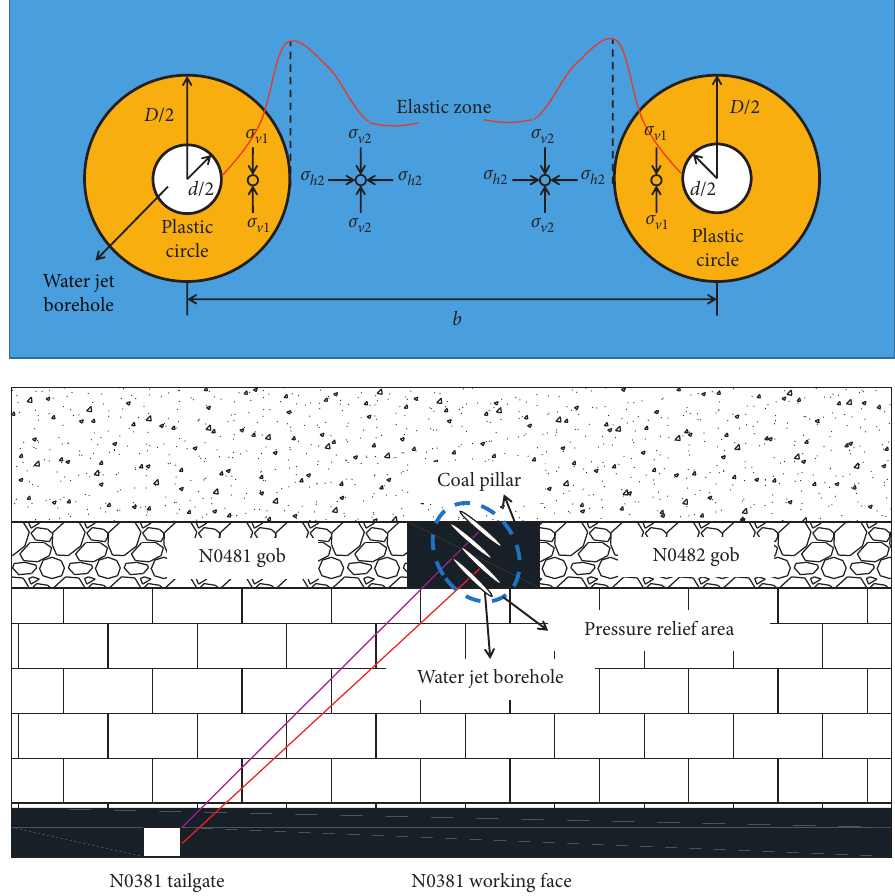
Figure 15: High-pressure water jet technology